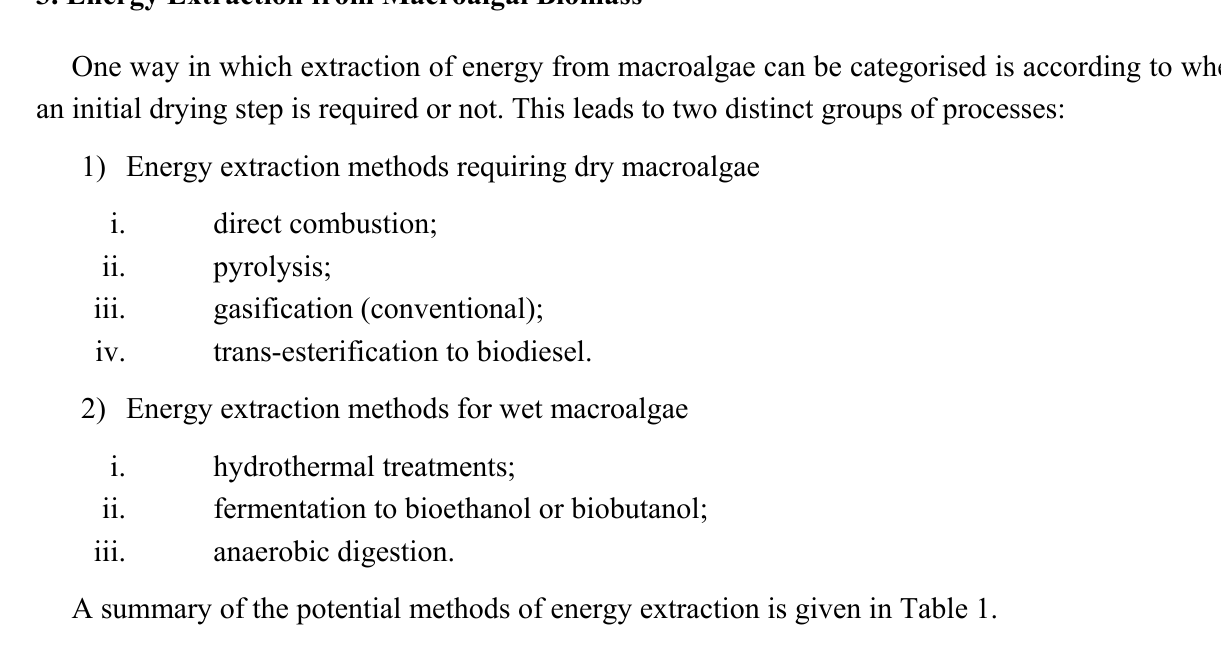
Table 1. Methods of energy extraction from macroalgal